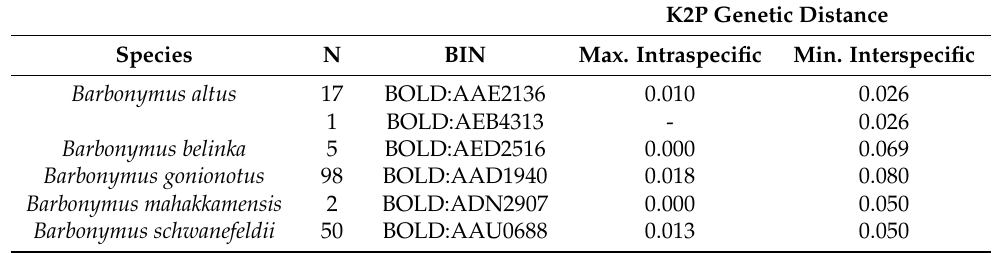
Table 2. Summary of genetic distances and MOTUs including species names, number of individuals analyzed, BOLD Barcode Index Number (BIN), maximum intraspecific and minimum interspecific K2P genetic distances.